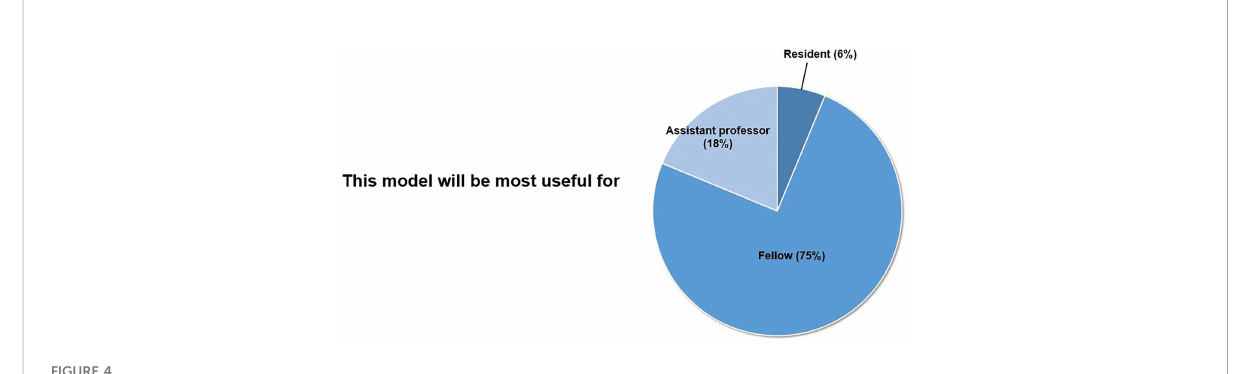
FIGURE 4 Usefulness as a training